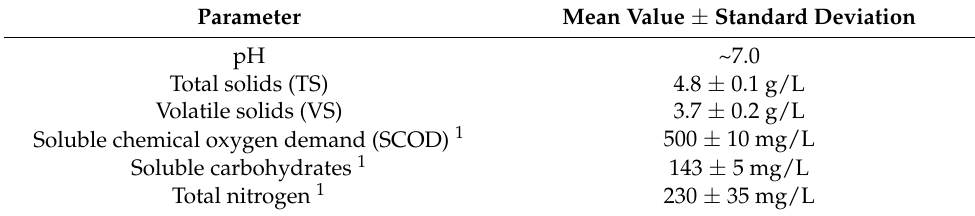
Table 2. Characteristics of raw waste-activated sludge